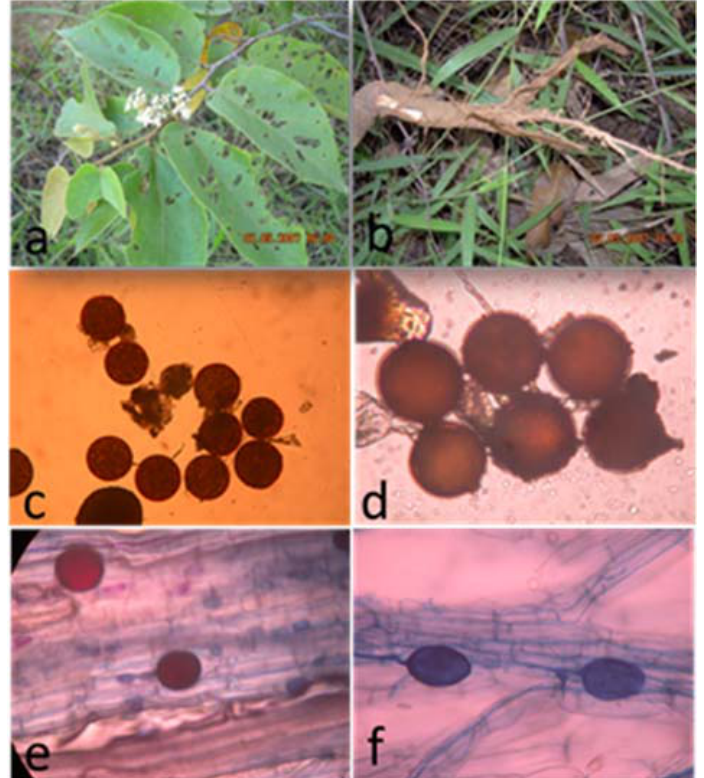
Figure 8. Native arbuscular mycorrhizal (AM) fungi colonized the shrub roots of Commersonia bartramia (Sterculiaceae) in degraded post-coal-mining lands in South Kalimantan, Indonesia; ( a , b ) shoot and roots of C. bartramia ; ( c , d ) spore of native AM fungi associated in the rhizosphere of shrub growing in post-mining lands; ( e , f ) arbuscules and vesicles found in root systems of C. bartramia . Symbiotic soil microbes play an important role in determining the performance of planted seedlings. The lack of population and diversity of symbiotic soil microbes in mining land will retard the natural succession process, thus hampering the success of restoring post-mining land. The AMF genera found in the East Kalimantan post-mining areas were Acaulospora and Glomus [147], while in South Sumatra, post-coal-mining areas were Glomus , Gigaspora , and Acaulospora [148]. A scant AMF population was also found in the coal post-mining areas in Muaro Jambi. The AMF spore density in the areas was less than four spores per 100 g of soil samples [127]. A parallel condition was also found in the nickel post-mining areas in South Sulawesi and Southeast Sulawesi. The types of mycorrhizal fungi found in both locations were Acaulospora and Glomus , with a very low spore density with less than 80 spores per 100 g of soil samples